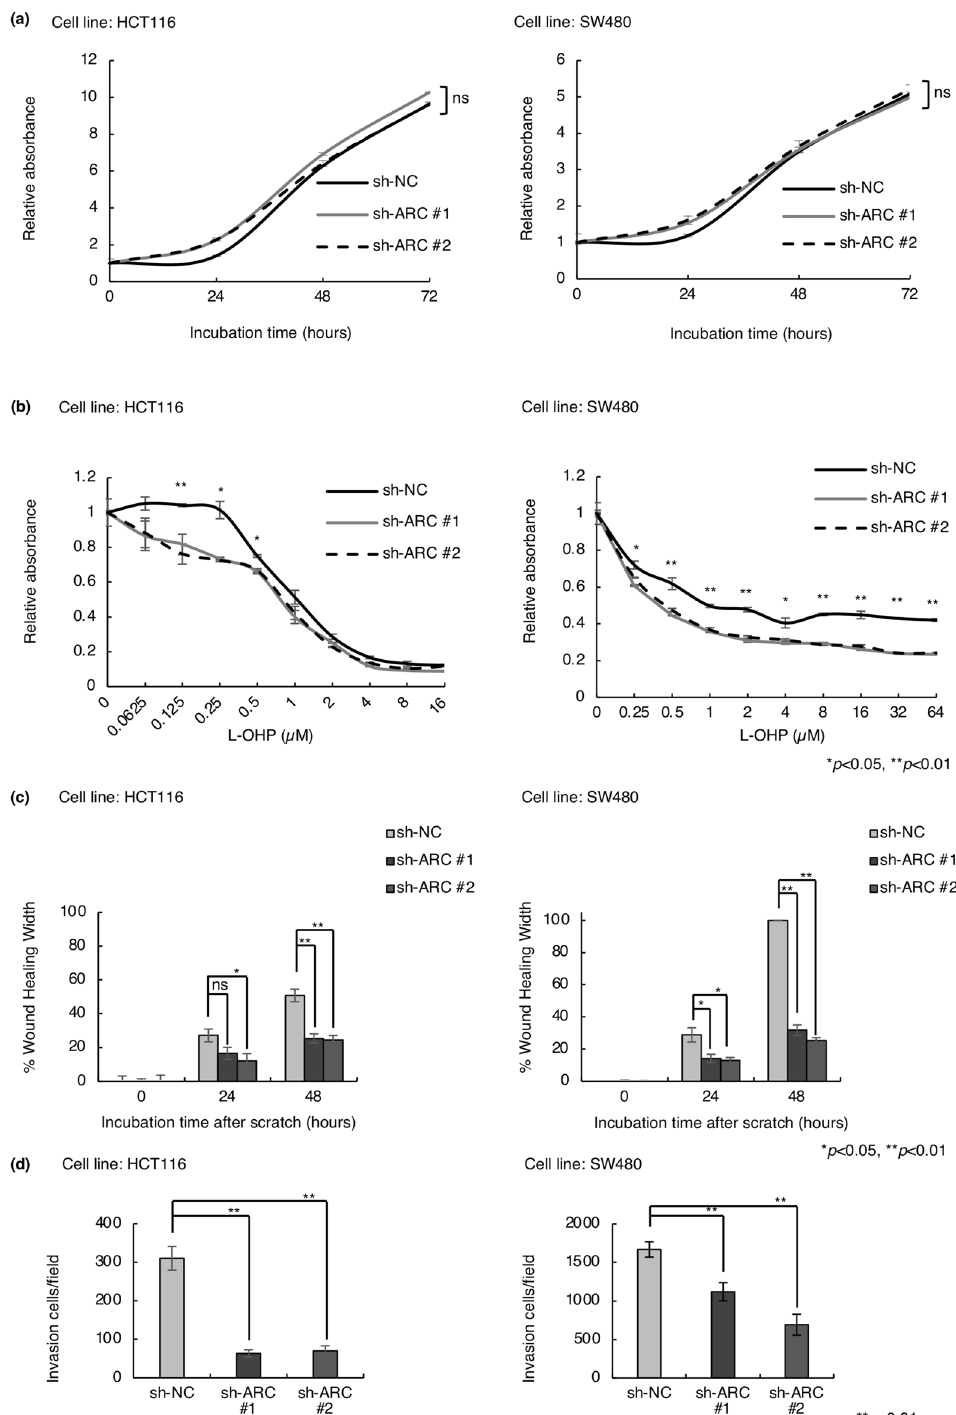
Figure 4. Alteration of cell proliferation, drug sensitivity, migration capacity, and invasion capacity by knockdown of ARC. ( a ) Cell proliferation assay in HCT116 and SW480 cells expressing sh-NC and sh-ARC. ( b ) Chemosensitivity assay to L-OHP in HCT116 and SW480 cells expressing sh-NC and sh-ARC. ( c ) Scratch wound healing assay in HCT116 and SW480 cells expressing sh-NC and sh-ARC. ( d ) Cell invasion assay in HCT116 and SW480 cells expressing sh-NC and sh-ARC. All experiments were conducted in triplicate. Error bars represent standard errors of the mean. Asterisks denote significant differences using the unpaired 2-tail t-test (* p < 0.05, ** p < 0.01). Sh short hairpin, NC negative control, L-OHP